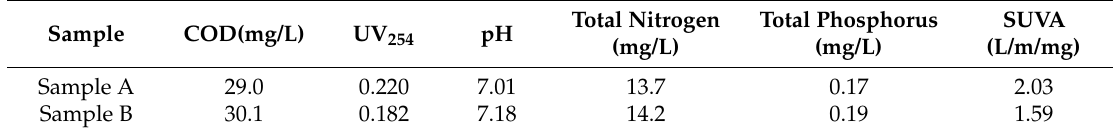
Table 2. Conventional raw water quality.